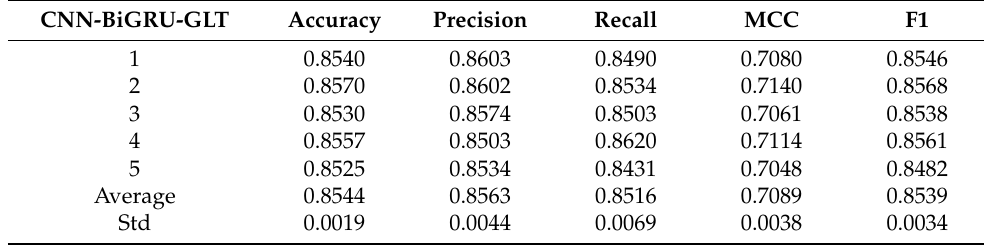
Table 5. Results of repeating the experiment five times for the CNN-BiGRU-GLT